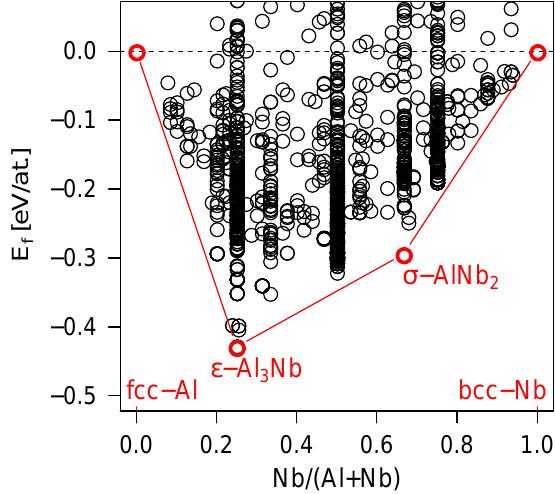
Figure 2. Energy of formation, E f , of various Al 1 − x Nb x structures predicted by first-principles evolutionary algorithm USPEX as a function of the Nb content. The convex hull line (red) connects the stable